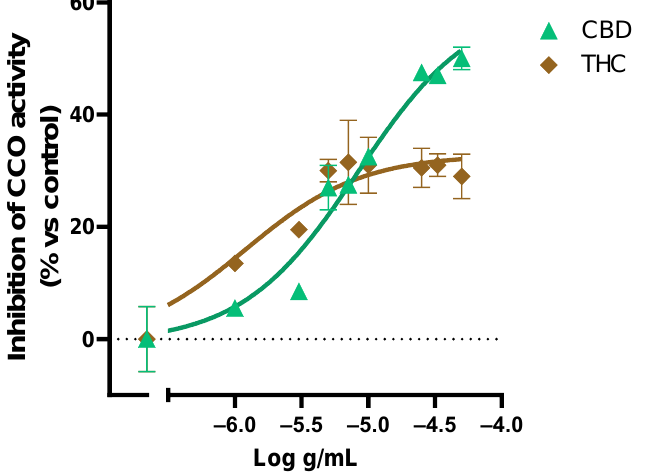
Figure 6. Effect of CBD and THC on the CCO activity expressed as a percentage over the basal activity in the presence of vehicle. Data are mean ± SEM values.